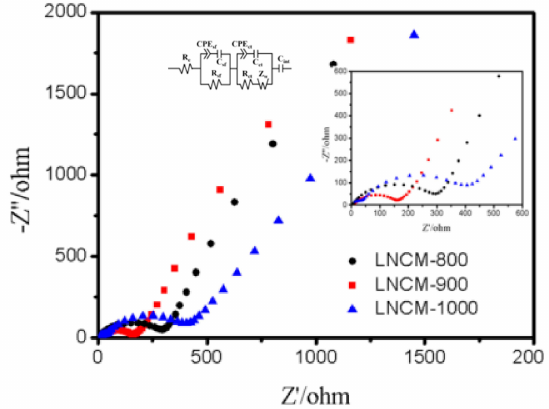
Figure 4. The electrochemical impedance spectroscopy (EIS) curves of LCNM-800, LCNM-900, and